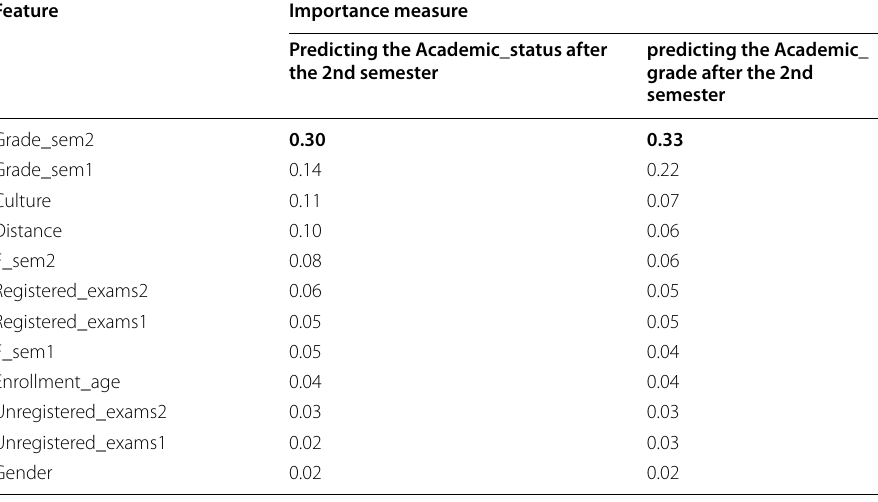
Bold values represent the features with most influence on the predictions